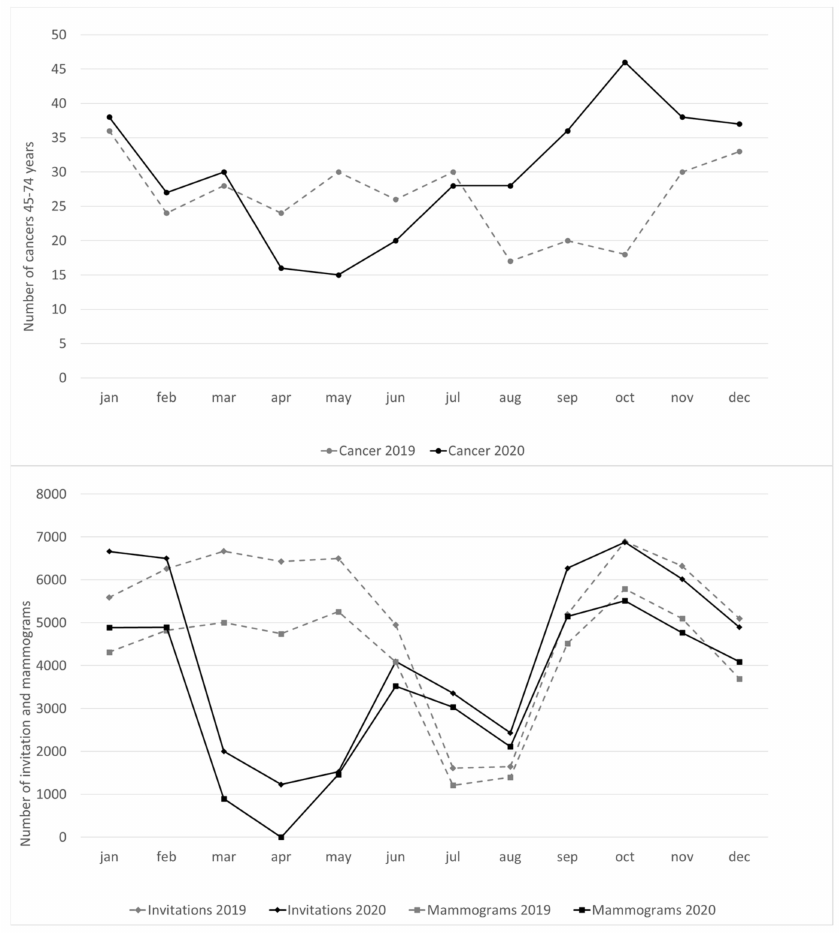
Figure 2. Number of cancers ( above ), and comparison with the number of invitations and mammo- grams ( below ), per month. Years